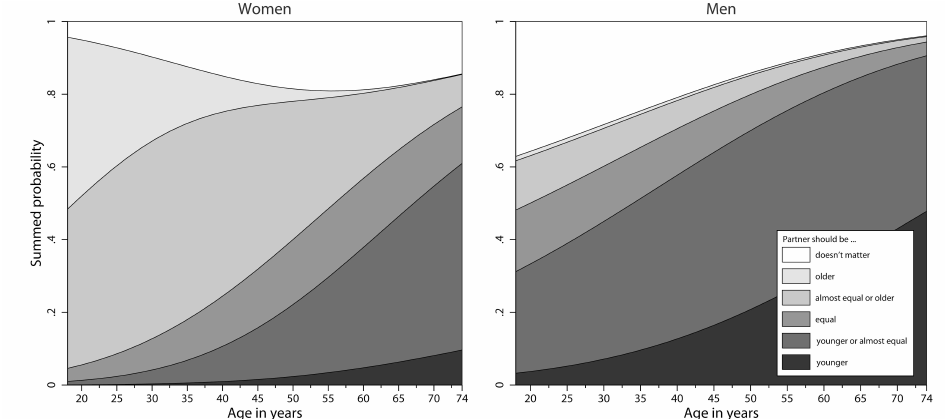
Figure 2 : Conditional effect of age on preference outcomes in men and